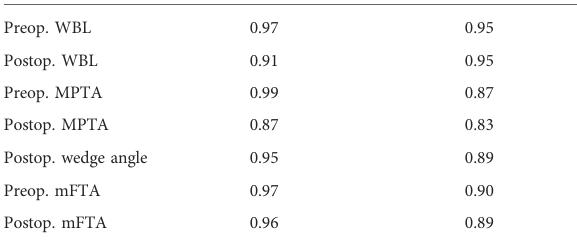
TABLE 2 Intraclass correlation coef fi cient of radiographic